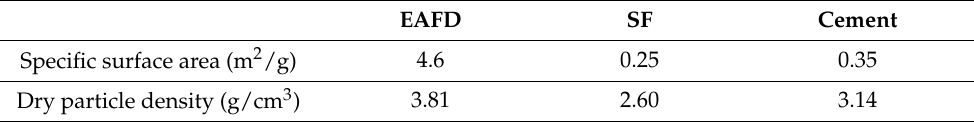
Table 2. Physical properties of EAFD, SF and Cement.